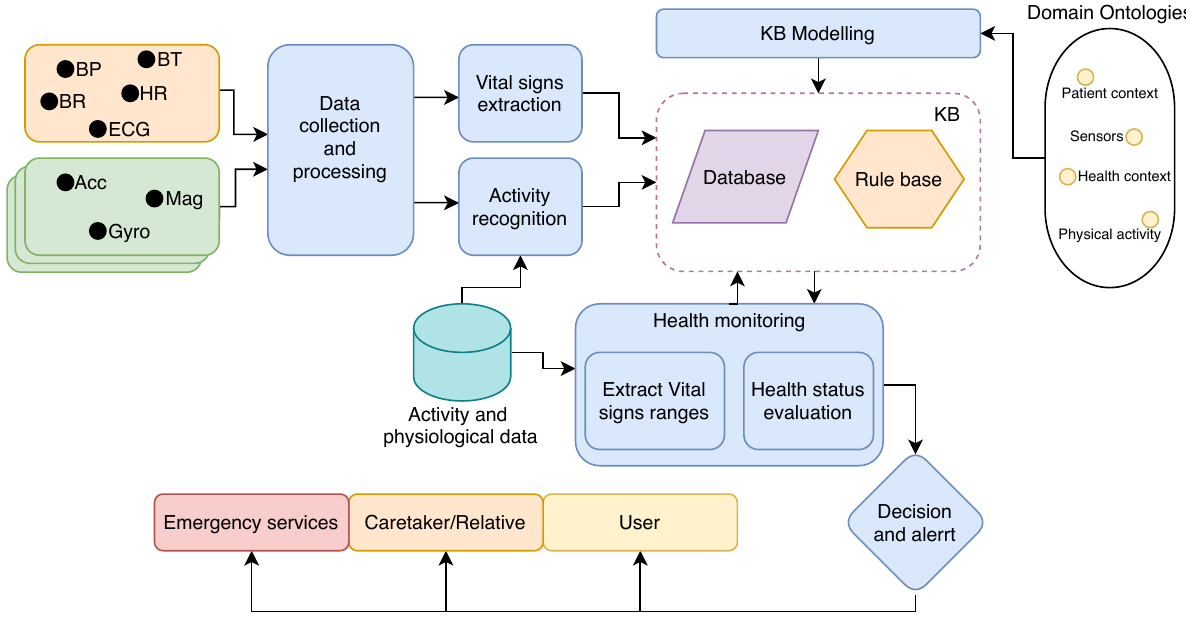
Figure 1. Proposed system’s